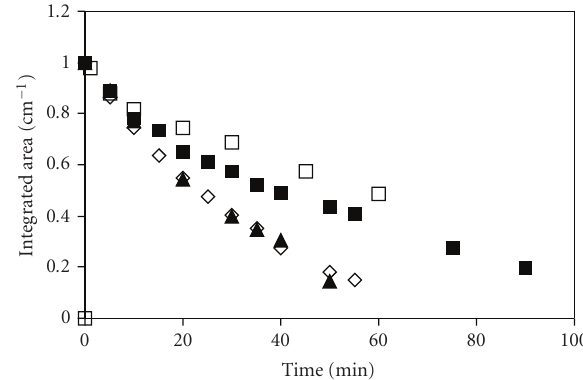
Figure 8: Photoactivity for the degradation of stearic acid (nor- malised) for Ag over TiO 2 (sample A (cid:2) , sample B (cid:4) ), reference TiO 2 (cid:4) and Ag on a commercial TiO 2 coating (cid:3)